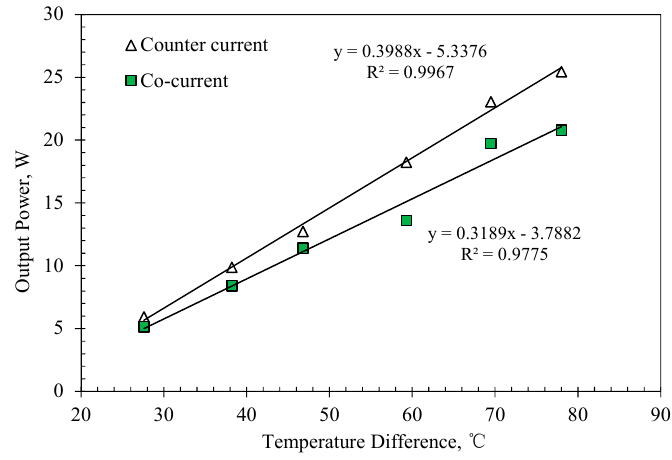
Figure 12. The effect of flow direction on output power.